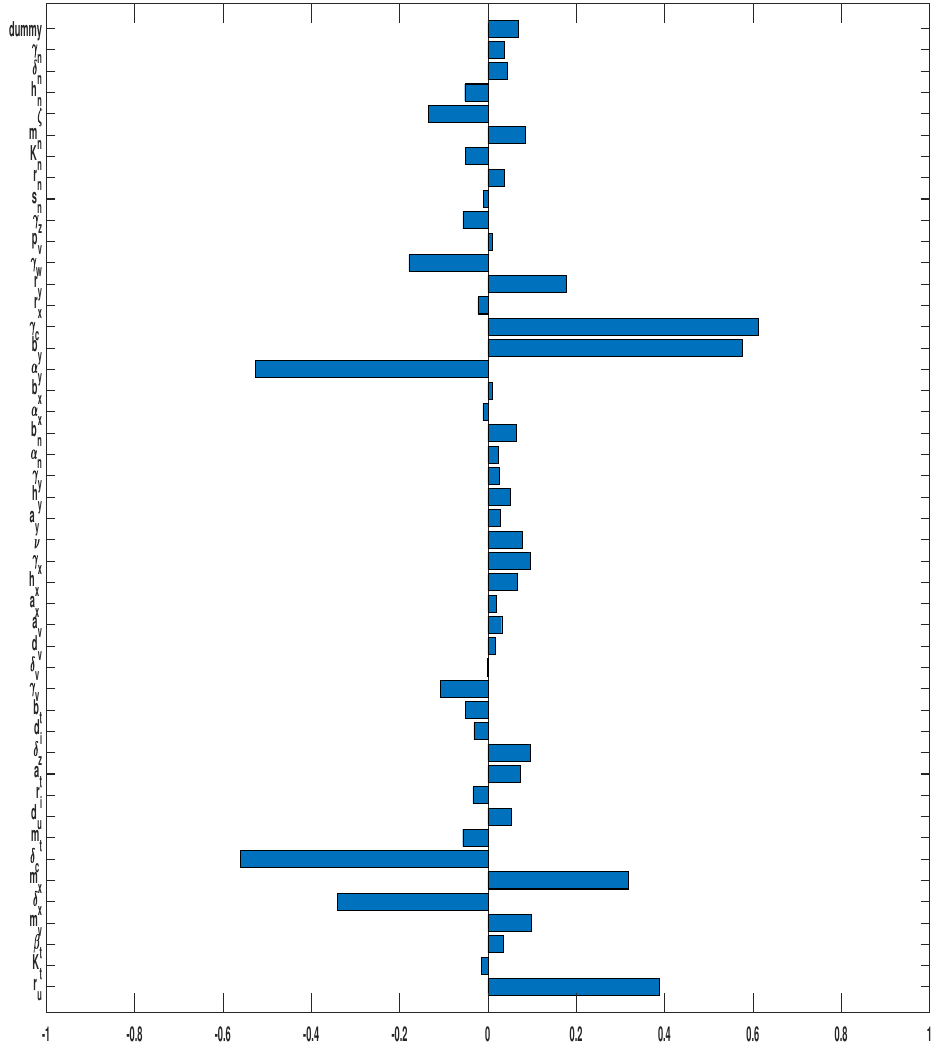
Figure 6. PRCC for the oncolytic virus parameters with anti-CTLA-4 against susceptible tumor cells. In all simulations, the tumor was treated with OVT and